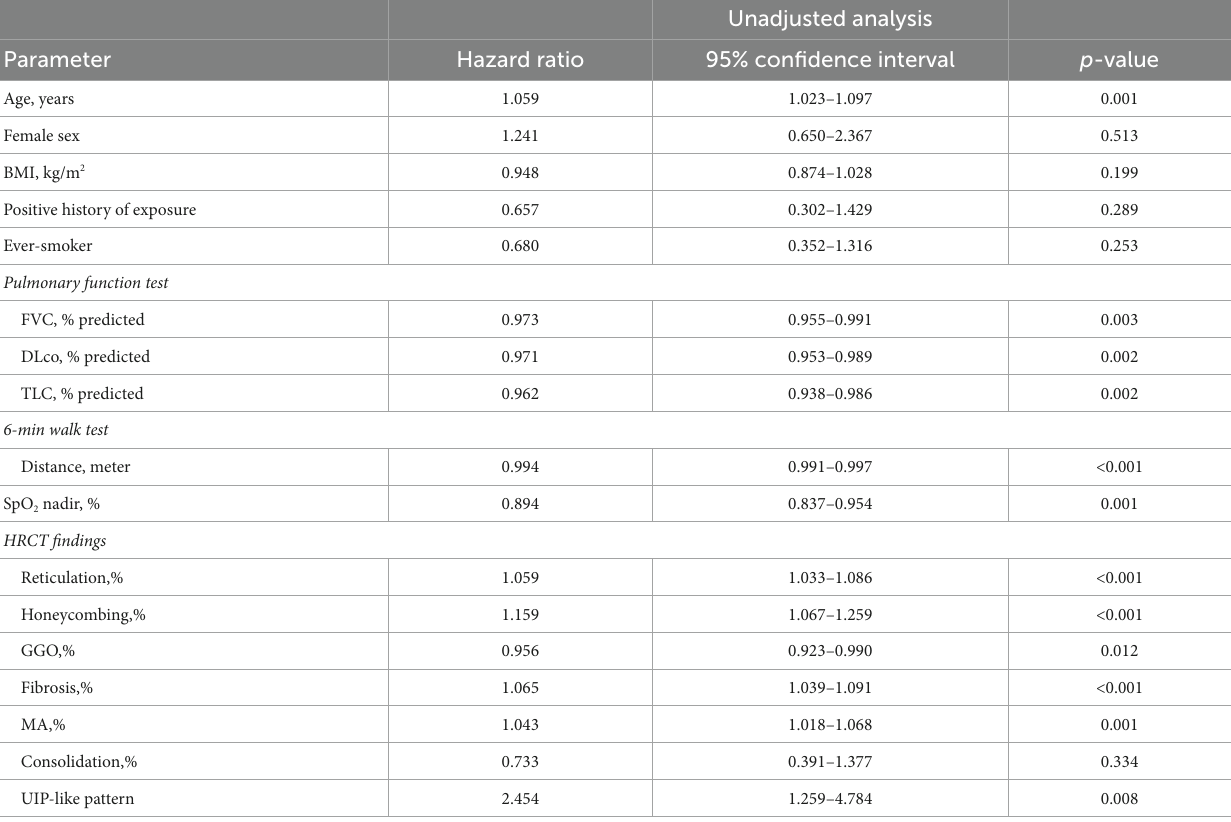
TABLE 3 Risk factor for mortality in patient with fibrotic HP using unadjusted Cox proportional hazards